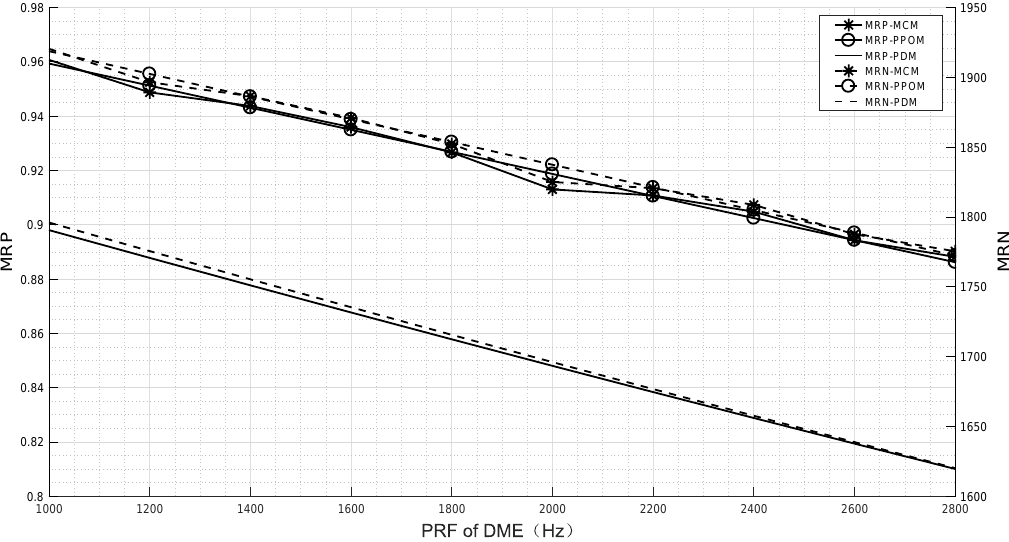
Figure 6. Mean Recognition Probability (MRP) and Mean Recognition Number (MRN) based on different